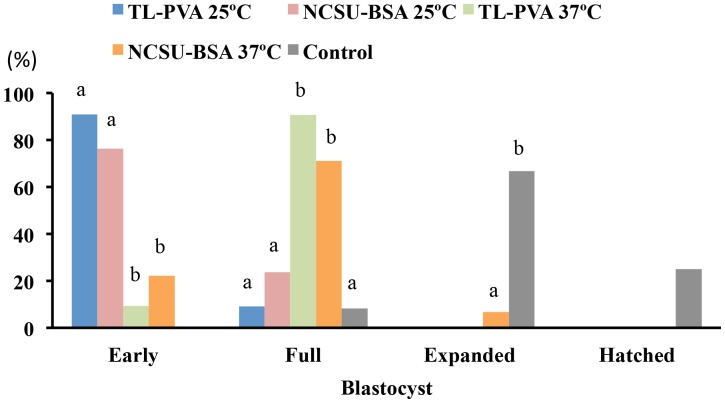
Frequency distribution of in vivo-derived morulae cultured for 24 h using different temperatures and media.Morulae were cultured in closed Eppendorf tubes containing 1.5 mL of TL-PVA or NCSU23-BSA media, supplemented with 10 mM HEPES, at 25°C or 37°C. Controls were morulae cultured in 4-well multi-dish plates, with each well containing 500 µL of NCSU-23 medium supplemented with BSA and fetal calf serum, at 38.5°C in humidified air with 5% CO2. Different letters within each blastocyst stage represent differences (p<0.001) in developmental frequencies among groups.